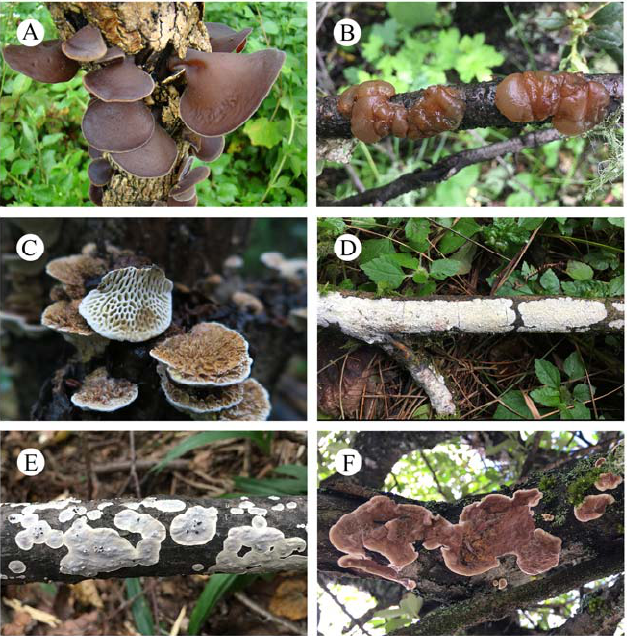
Figure 1. Representative taxa of Auriculariaceae. ( A ). Auricularia cornea Ehrenb.; ( B ). Exidia sp.; ( C ). Elmerina sp.; ( D ). Alloexidiopsis calcea (Pers.) L.W. Zhou and S.L. Liu; ( E ). Eichleriella crocata (Pat.) Spirin and Malysheva; ( F ). Heteroradulum kmetii .